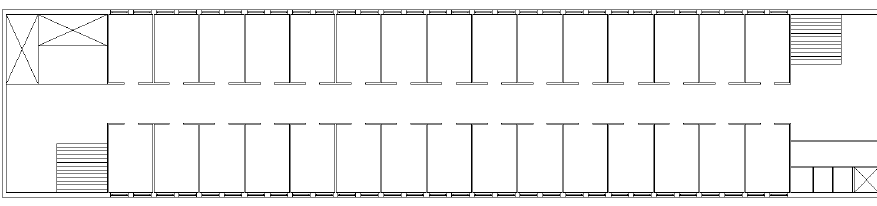
Figure 3. Plan of a typical floor of the office building.